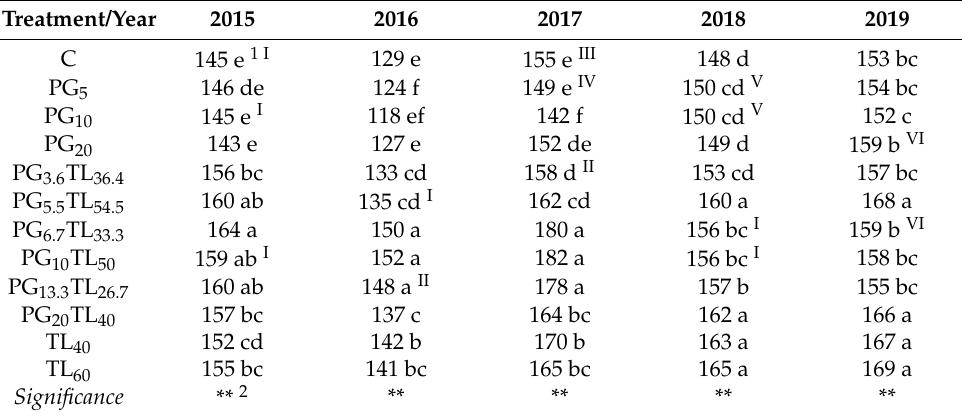
Table 4. Effect of treatments and years on the soil moisture reserves (mm) in 0–50 cm layer.